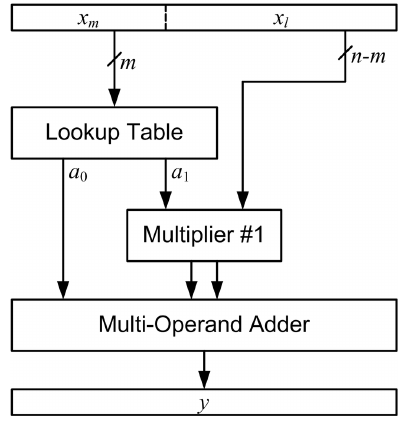
Figure 2. Linear interpolator block